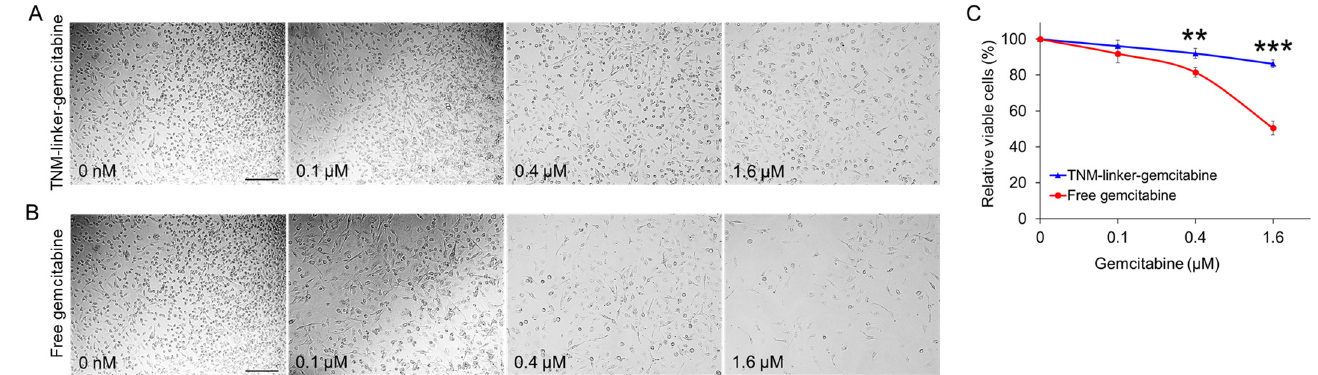
Figure 5. linker–gemcitabineTNM–linker–gemcitabine has minimal cytotoxicity compared to free gemcitabine. Cultured tumor cells (MDA-MB-231) were treated for 30 min with linker–gemcitabi- neTNM–linker–gemcitabine ( A ) or free gemcitabine ( B ) at different concentrations as indicated. Treatment concentrations were adjusted to reflect an equimolar amount of gemcitabine. After treat- ment, cells were washed and cultured in fresh medium for two days. At the endpoint, cell cultures were examined and imaged under a light microscope ( A , B ), and cell proliferation rates were evalu- ated by CCK-8 proliferation assay ( C ). Scale bar = 200 µm. p ≤ 0.05 was considered significant. **: p